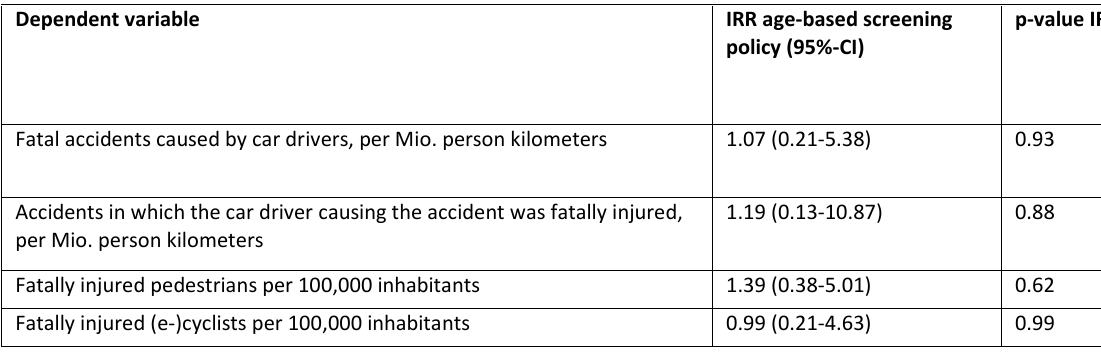
Table S3: Results of the Poisson regression analyses for fatal accidents or injuries. Incidence rate ratios (IRR) for the variable "age-based screening policy" (persons aged 70 years or older in Switzerland) with corresponding 95% confidence intervals (CI) and